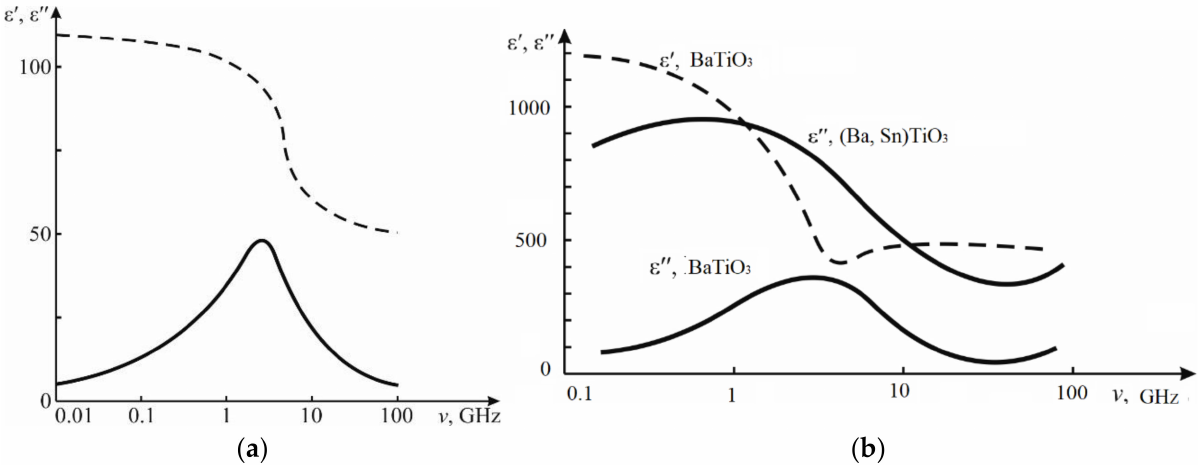
Figure 6. Microwave permittivity dispersion and absorption in displacement-type ferroelectrics: ( a ) lead titanate (PbTiO 3 ); ( b ) barium titanate (BaTiO 3 ) and solid solution (Ba, Sn)TiO 3 [14].